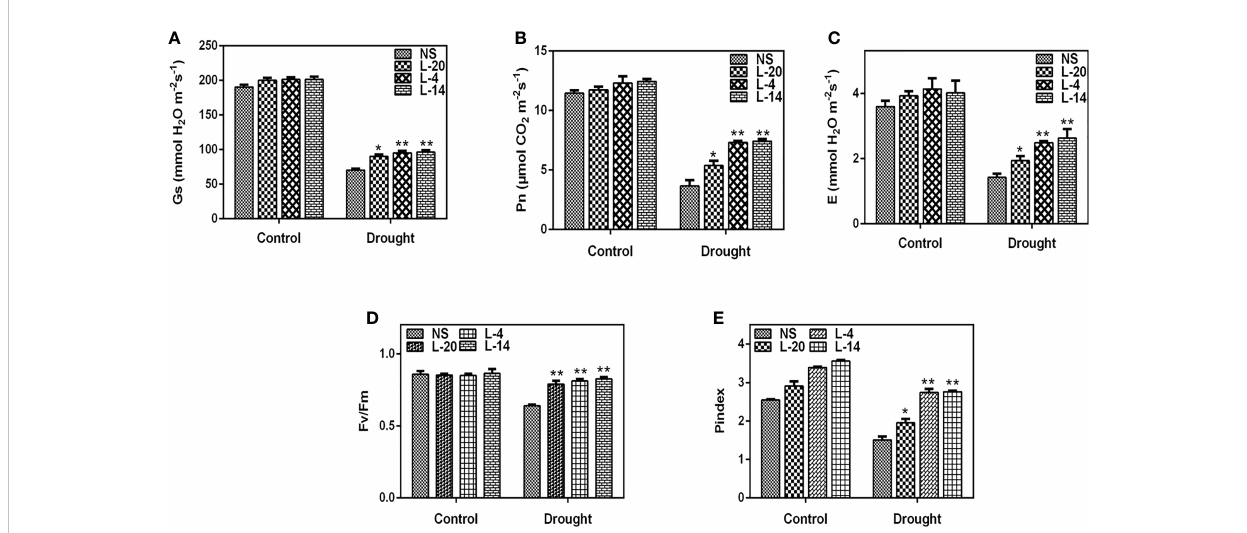
FIGURE 9 Effect of drought treatment on leaf gas exchange parameter and chlorophyll fl uorescence of tobacco transgenics harboring VaDJI after 14 days of drought stress; (A) g s – measurement of stomatal conductance, (B) P n - measurement of net photosynthetic rate), (C) E- measurement of transpiration rate, (D) F v /F m - measurement of PSII photochemistry ef fi ciency, (E) PI abs - measurement of performance index. The values indicate mean ± SE. *statistically signi fi cantly different at p ≤ .05 and **statistically signi fi cantly different at p ≤ 0.01 level as compared to